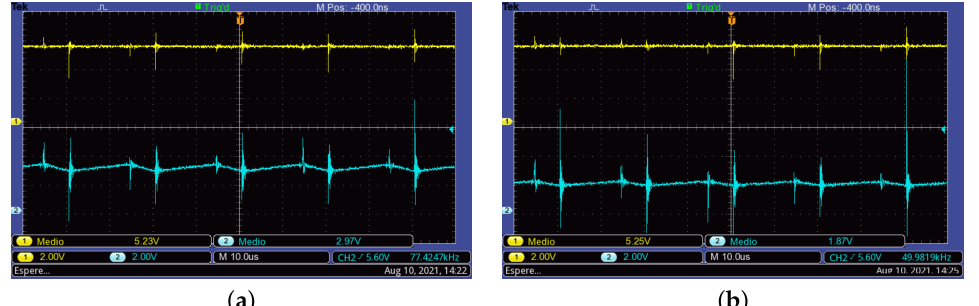
Figure 14. Inductor and PV module currents. ( a ) PV module ( Top ) and inductor L 1 ( Bottom ). ( b ) PV module ( Top ) and inductor L 2 ( Bottom ).